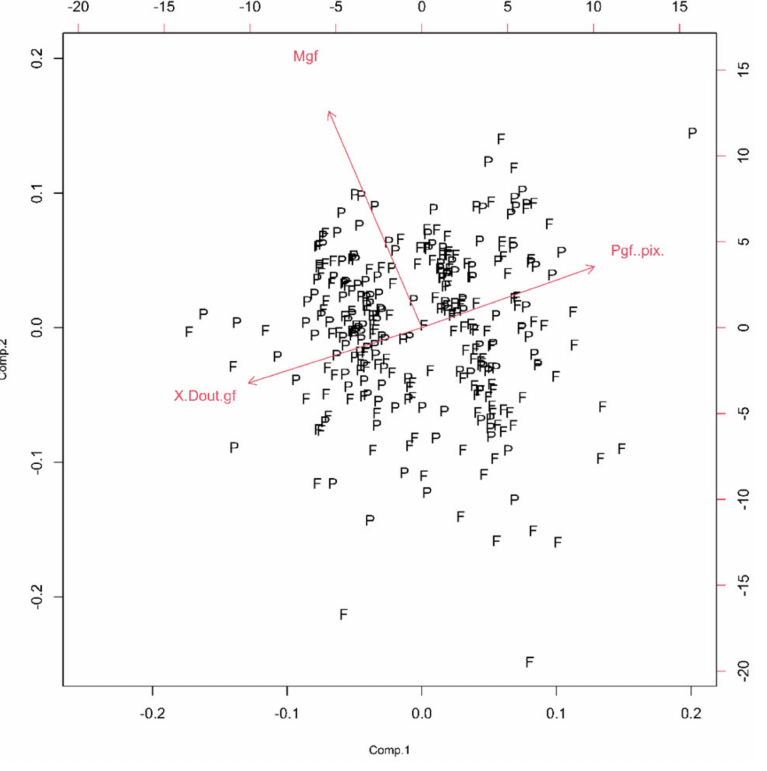
Figure 5. The PCA-based bi-plots of parameters characterizing morphological features in the given parameter space. Relationships between the first two standardized principal components of the